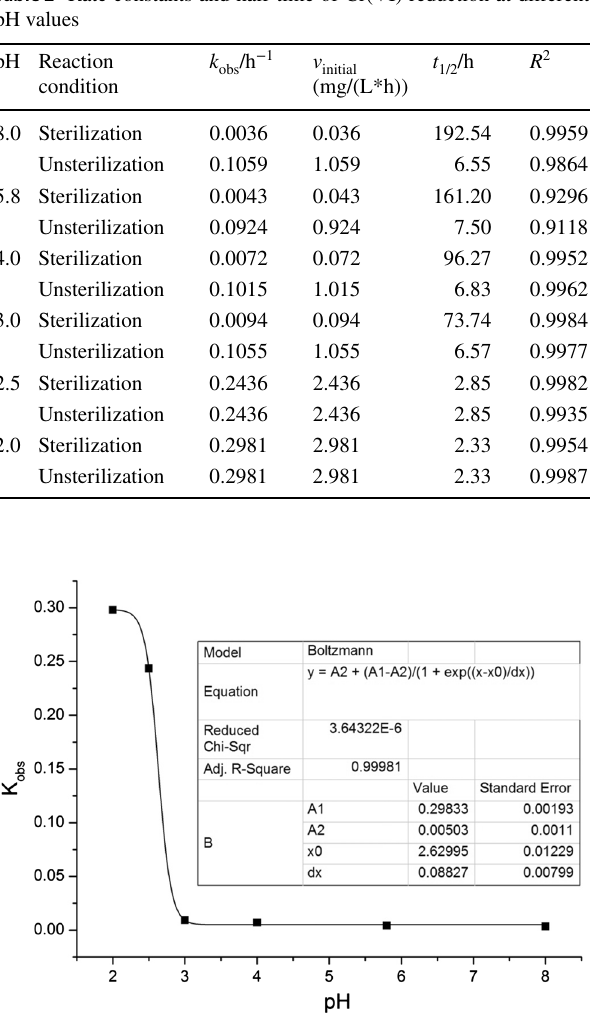
Fig. 2 Relationship between the k zation